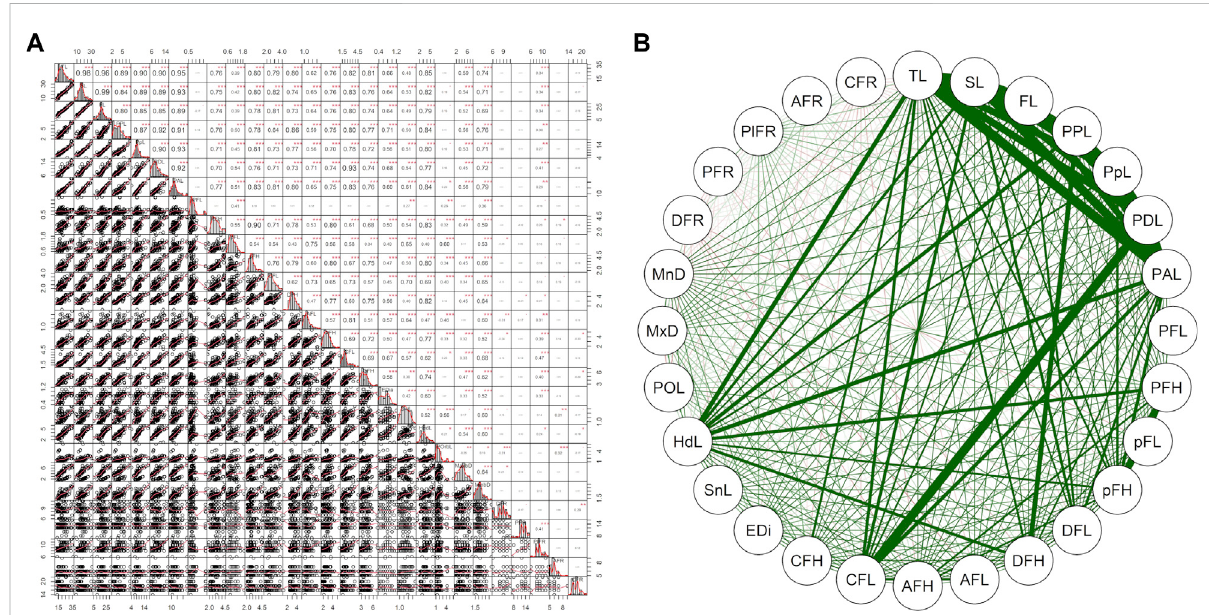
FIGURE 5 (A) Thecorrelationplotamongthemorphometricparameteramongsix fi shspeciescollectedfromRiverPoonch.Thevaluegivenaroundallthe axes are the range of each species parameter s measured unit values (cm). Correlation coef fi cients (r) are indicated with numeric values, with signi fi cant levels (p) are denoted by asterisks (* < .05, ** < .01, *** < .001) and (B) presenting same in diagrammatic